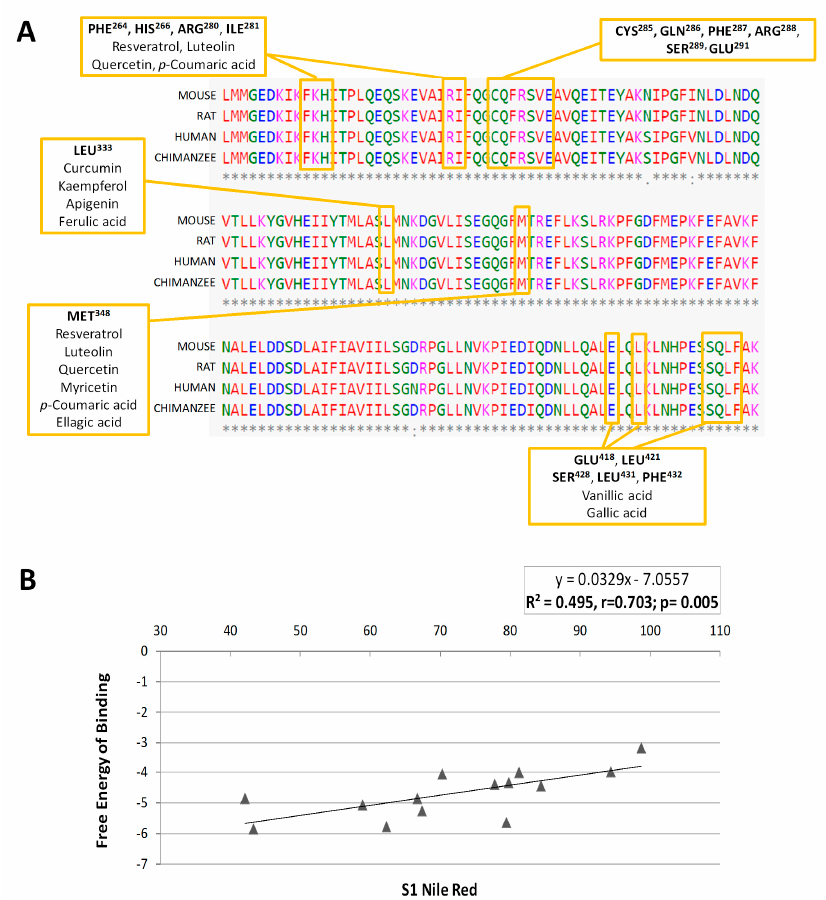
Figure 6. ( A ) Protein sequence of the PPAR γ LBD implicated in the interactions with the phenolic compounds. The amino acid sequence is highly conserved between human and rat, mouse and chimpanzee proteins. The text boxes indicate the main amino acid residues with which the different phenolic compounds interact. ( B ) Representation of the Pearson correlation analysis between the inhibitory activity on 3T3-L1 adipogenesis in the S1 assay (quantified by Nile Red staining) and the free energy of binding (kcal/mol) for each compound to PPAR γ protein. On the contrary, kaempferol exhibits a particular binding pattern (residues Cys285, Arg288 and Leu333), different from the other studied flavonols, but similar to curcumin. This specific interaction pattern could be related to their higher cytotoxic effects in vitro. On the other hand, the flavones apigenin and luteolin, which exhibited the best binding energy values, showed a completely different binding pattern. While luteolin reminds quercetin, resveratrol or p -coumaric acid, apigenin shares some amino acids with ferulic acid (the phenolic acid with the lowest binding affinity). However, as in the case of kaempferol and curcumin, apigenin also binds to Cys285 and Arg288, pointing to a key role of these amino acids in the binding pocket of the receptor. This difference might explain both the